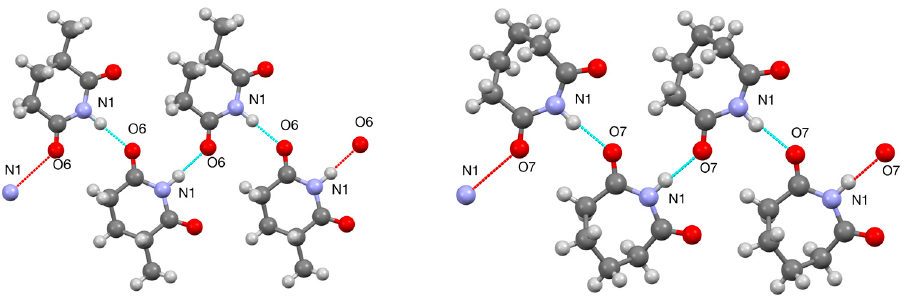
Figure 10. Hydrogen bonded C (4) structures for 9 and 13 .